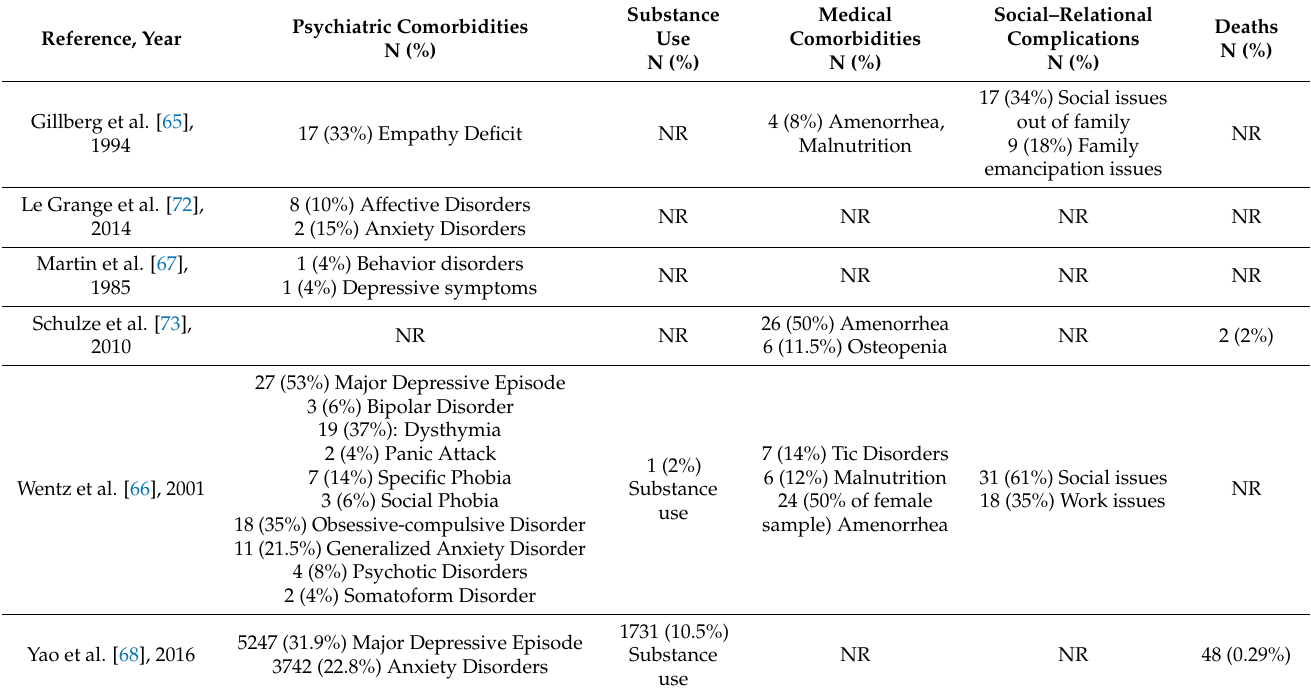
Table 2. Studies included in the qualitative analysis of medical and psychiatric comorbidities and substance use in EDs and associated social–relational